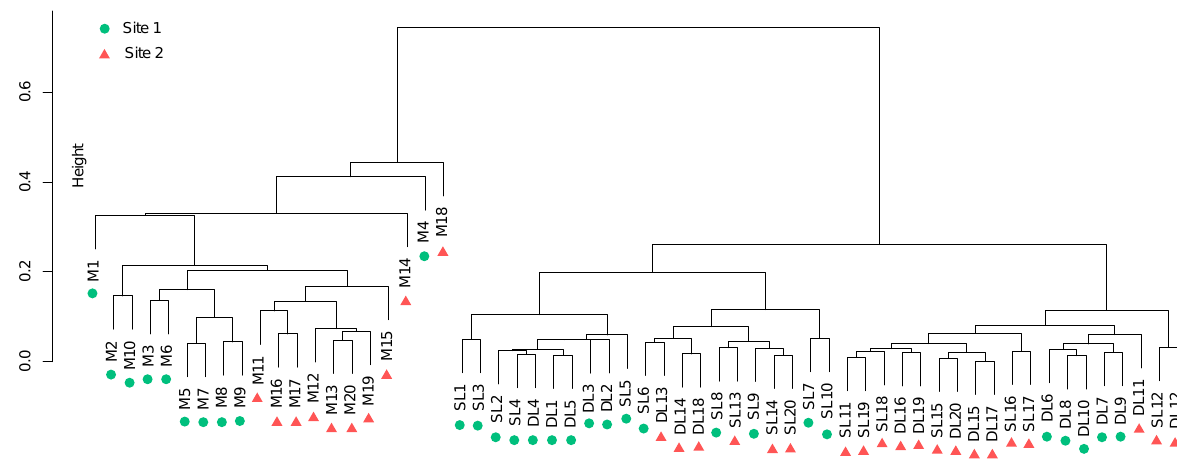
Fig. 6 Cluster dendrogram of the samples (mushrooms, surface soil layer, and deep soil) based on microelement content. Designa- tions of M1–20, SL1–20, and DL1–20 indicate the mushrooms (M), surface soil layer (SL), and deep soil samples (DL), respectively.